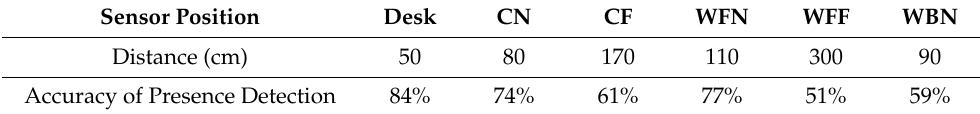
Table 1. Distance of sensors to the seated area and their presence detection accuracy. Sensor